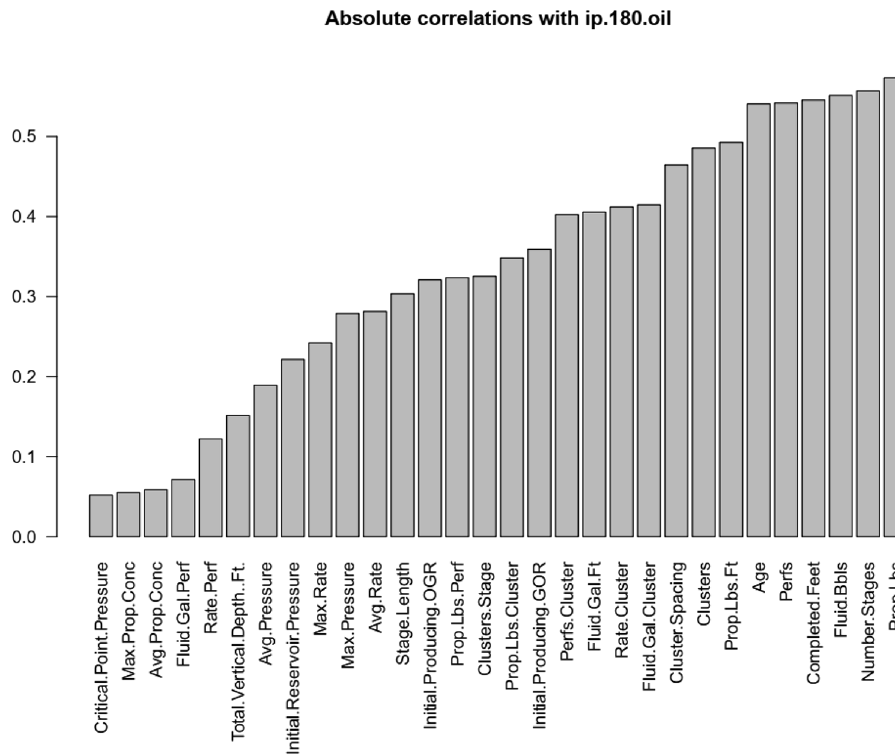
Fig. 3 Abs correlations of IP 180 Oil with each of the 30 variables used in the study